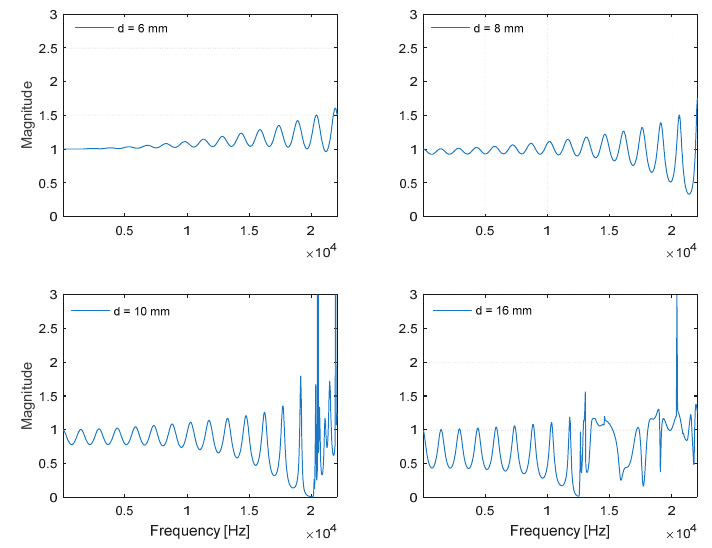
Figure 6. Plot matrix for simulated frequency response of cylindrical pipe ( l = 117.7 mm, h = 3 mm, and w = 8 mm) with selected diameters.